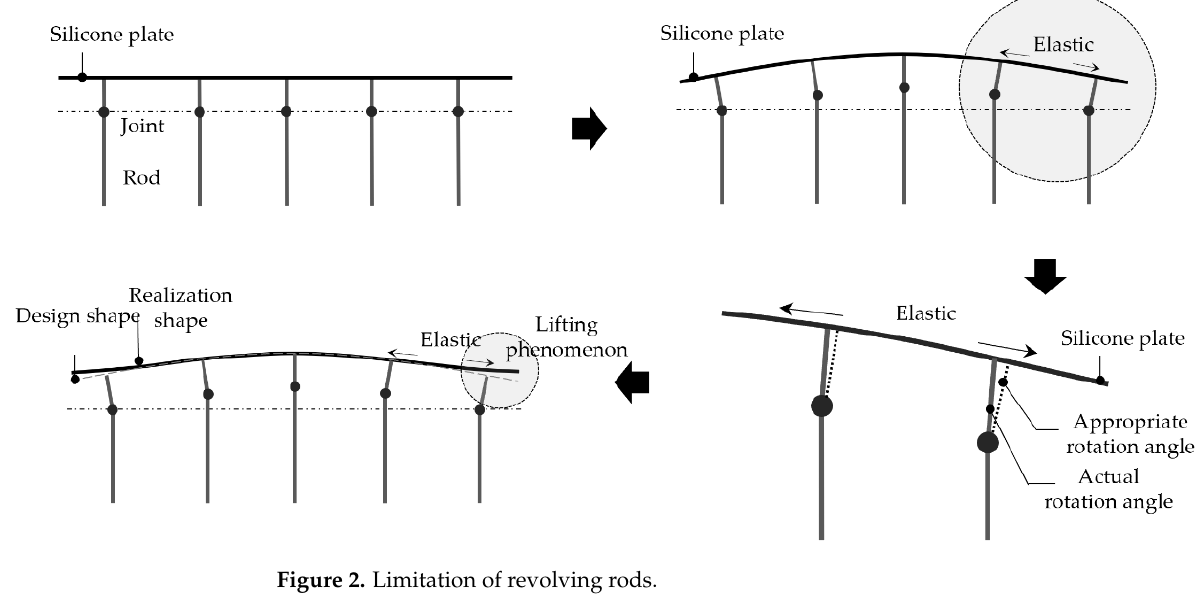
Figure 2. Limitation of revolving rods.